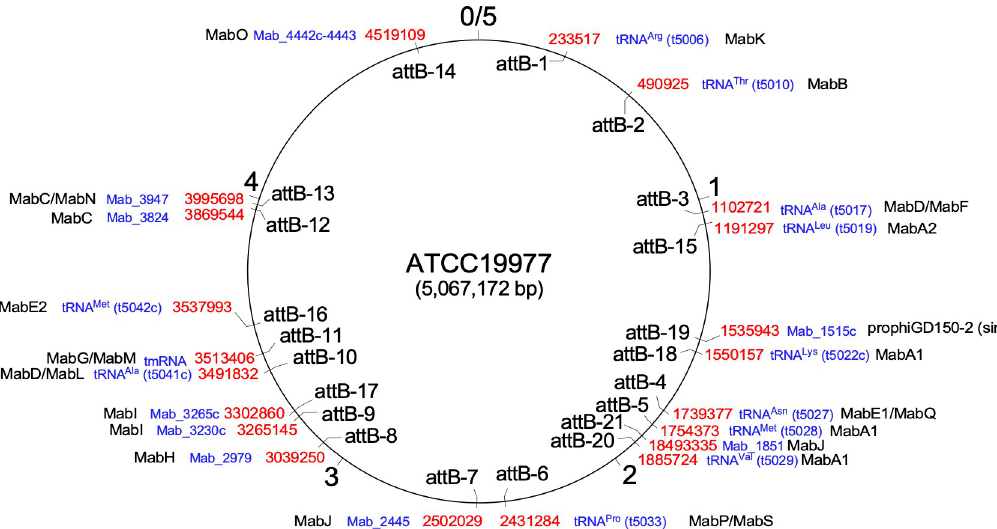
Fig 2. Locations of attB sites used by M . abscessus prophages. The attB sites in the M . abscessus ATCC19977 genome used by prophages characterized to date are shown. The 5 Mbp circular genome is represented, with the locations of 21 attB sites (attB- 1 to attB-21) indicated within the circle. Text outside of the circular genome indicates the attB coordinates (red), the gene it is in (blue), and the cluster(s) or subcluster(s) of the prophages that integrate into that site (black). The figure is adapted from Fig 3A in reference [30], which also shows the positions of attB1 –attB-18. The attB-19 site is used by prophiGD150-1 which will be described elsewhere. The attB-20 and attB-21 sites are newly identified in this study (see Table